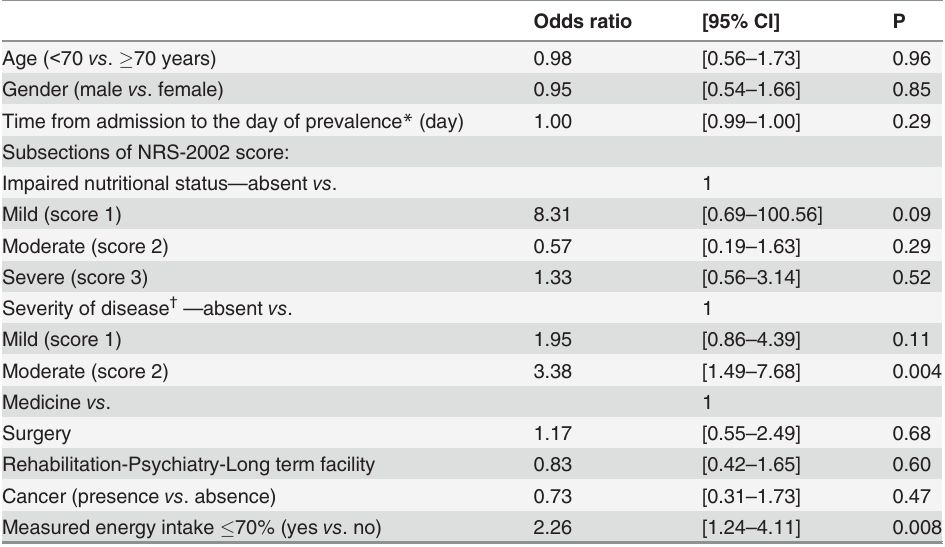
Table 3. Multivariate logistic analysis for parameters associated with healthcare-associated infections.